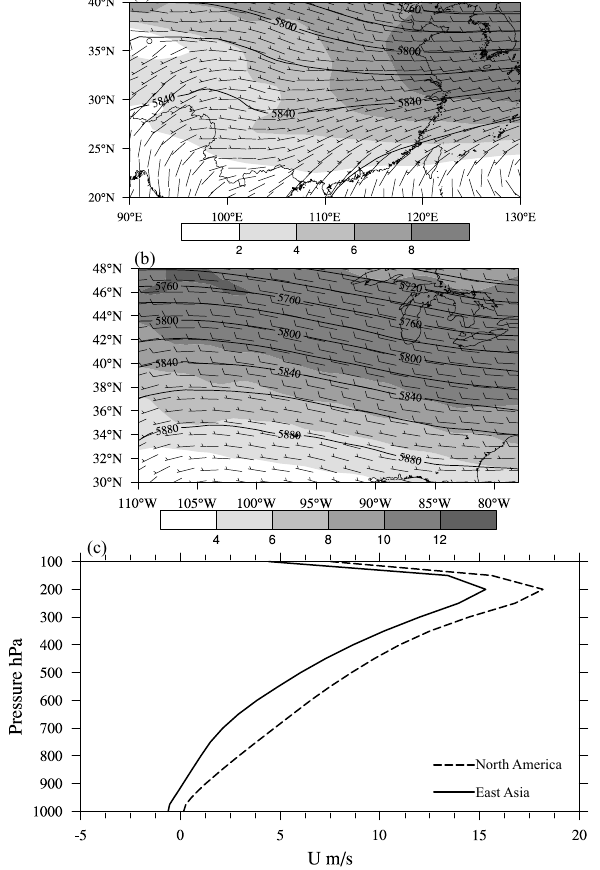
Figure 5. Map distributions of the 500hPa geopotential height (ev- Figure 5 . Map distributions of the 500-hPa geopotential height (every 20 dam), zonal wind 2 ery 20dam), zonal wind (shaded, units: ms − 1 ) and horizontal wind (shaded, units: ms -1 ) and horizontal wind barbs over (a) East Asia and (b) North America. (c) 3 barbs over (a) East Asia and (b) North America. (c) Vertical profile of the zonal mean speeds over both Vertical profile of the zonal mean speeds over both regions. 4